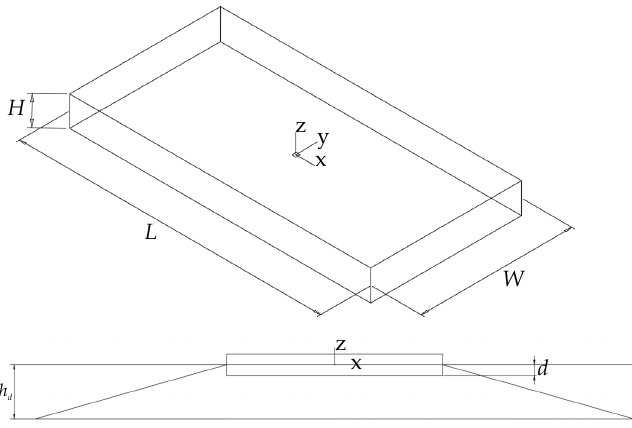
Figure 3. The investigated WEC with the illustration of the mooring